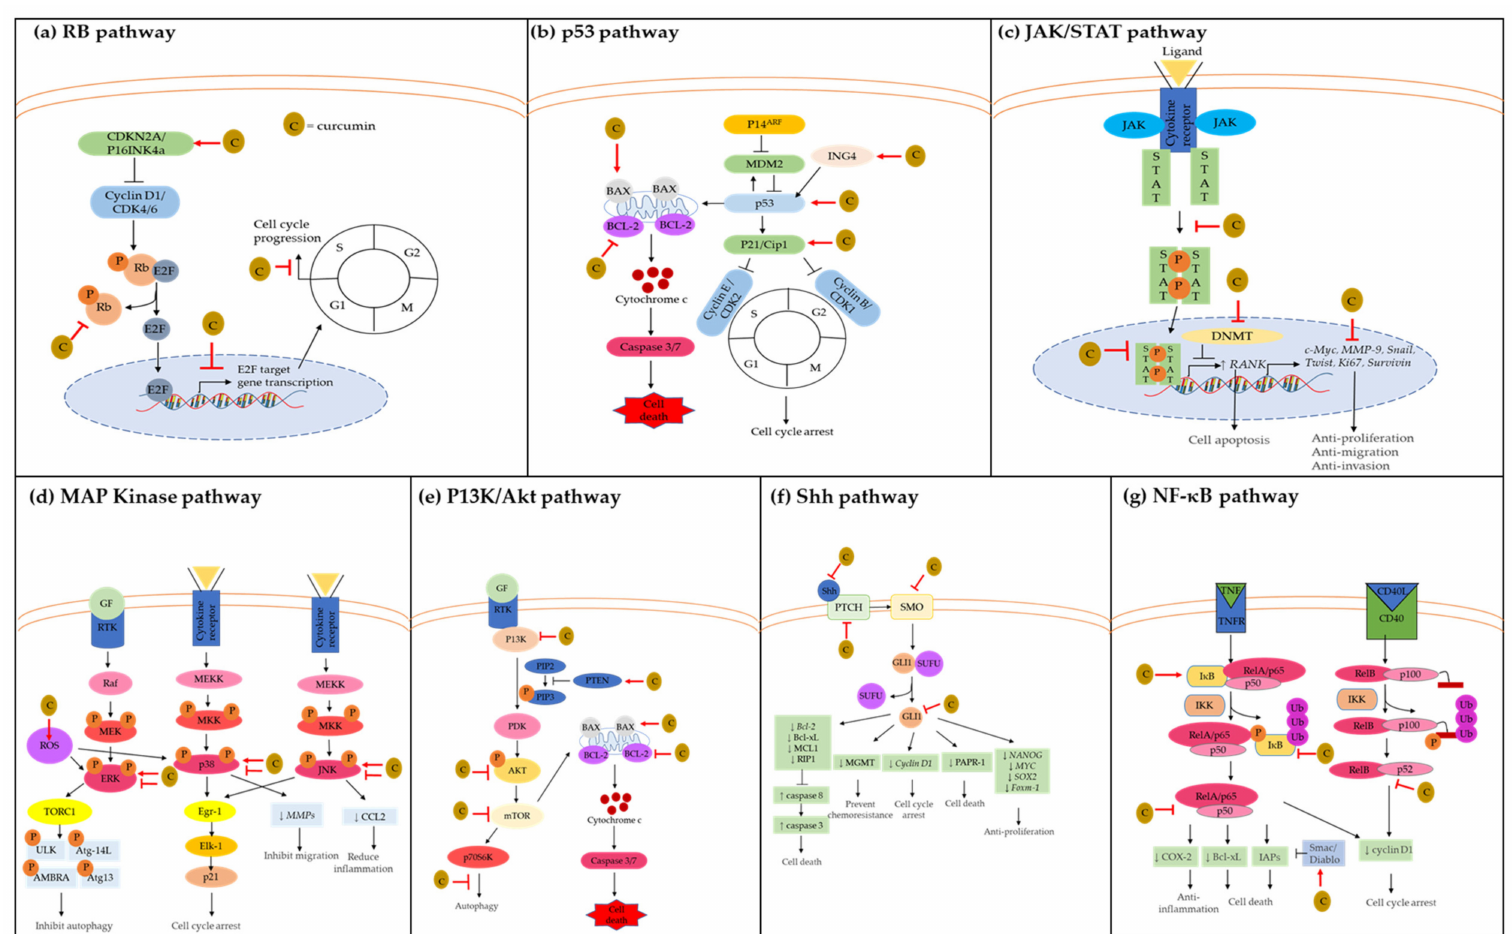
Figure 1. Mode of curcumin actions as anti-cancer agent on the key molecular targets in GBM. Curcumin possesses anti-cancer properties by inhibiting signaling pathways and their downstream molecular targets; ( a ) retinoblastoma (RB) pathway; ( b ) p53 pathway; ( c ) JAK1,2/STAT3 pathway; ( d ) MAP kinase pathway; ( e ) P13K/Akt pathway; ( f ) Shh pathway; ( g ) NF- κ B pathway. Molecular targets and signaling pathways that are upregulated and downregulated by curcumin are noted by using → and (cid:97) ,